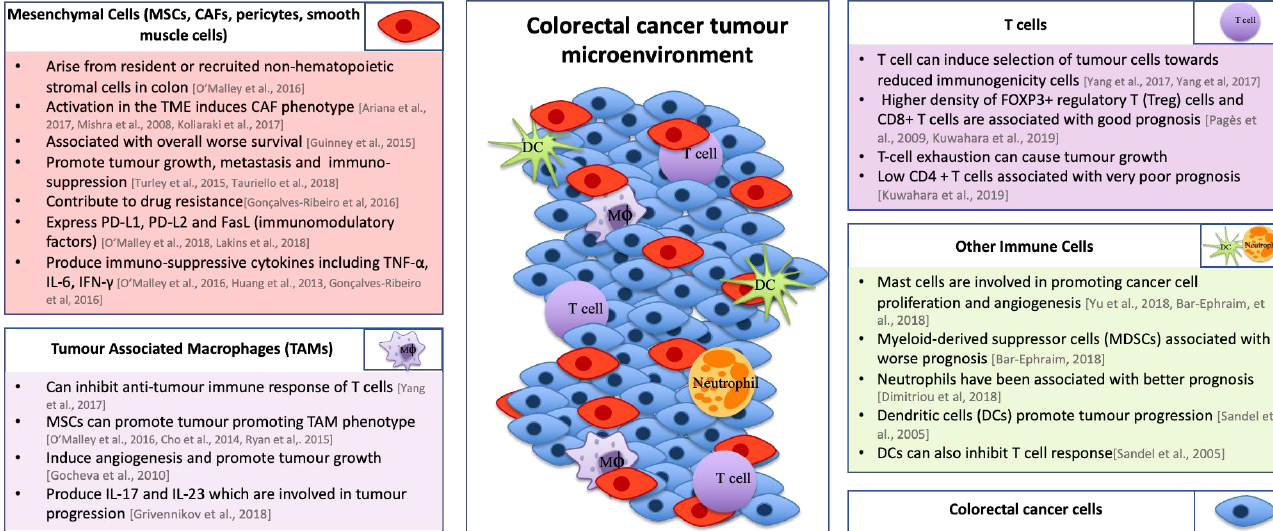
Figure 2. The role of various cells in the tumor microenvironment of colorectal cancer. The diagram in the centre of this figure represents the tumor microenvironment (TME) of CRC. This figure summarises the role that different cells play in the TME of CRC [16,17,55,56,59–65,68,69,77–80,82–88] .